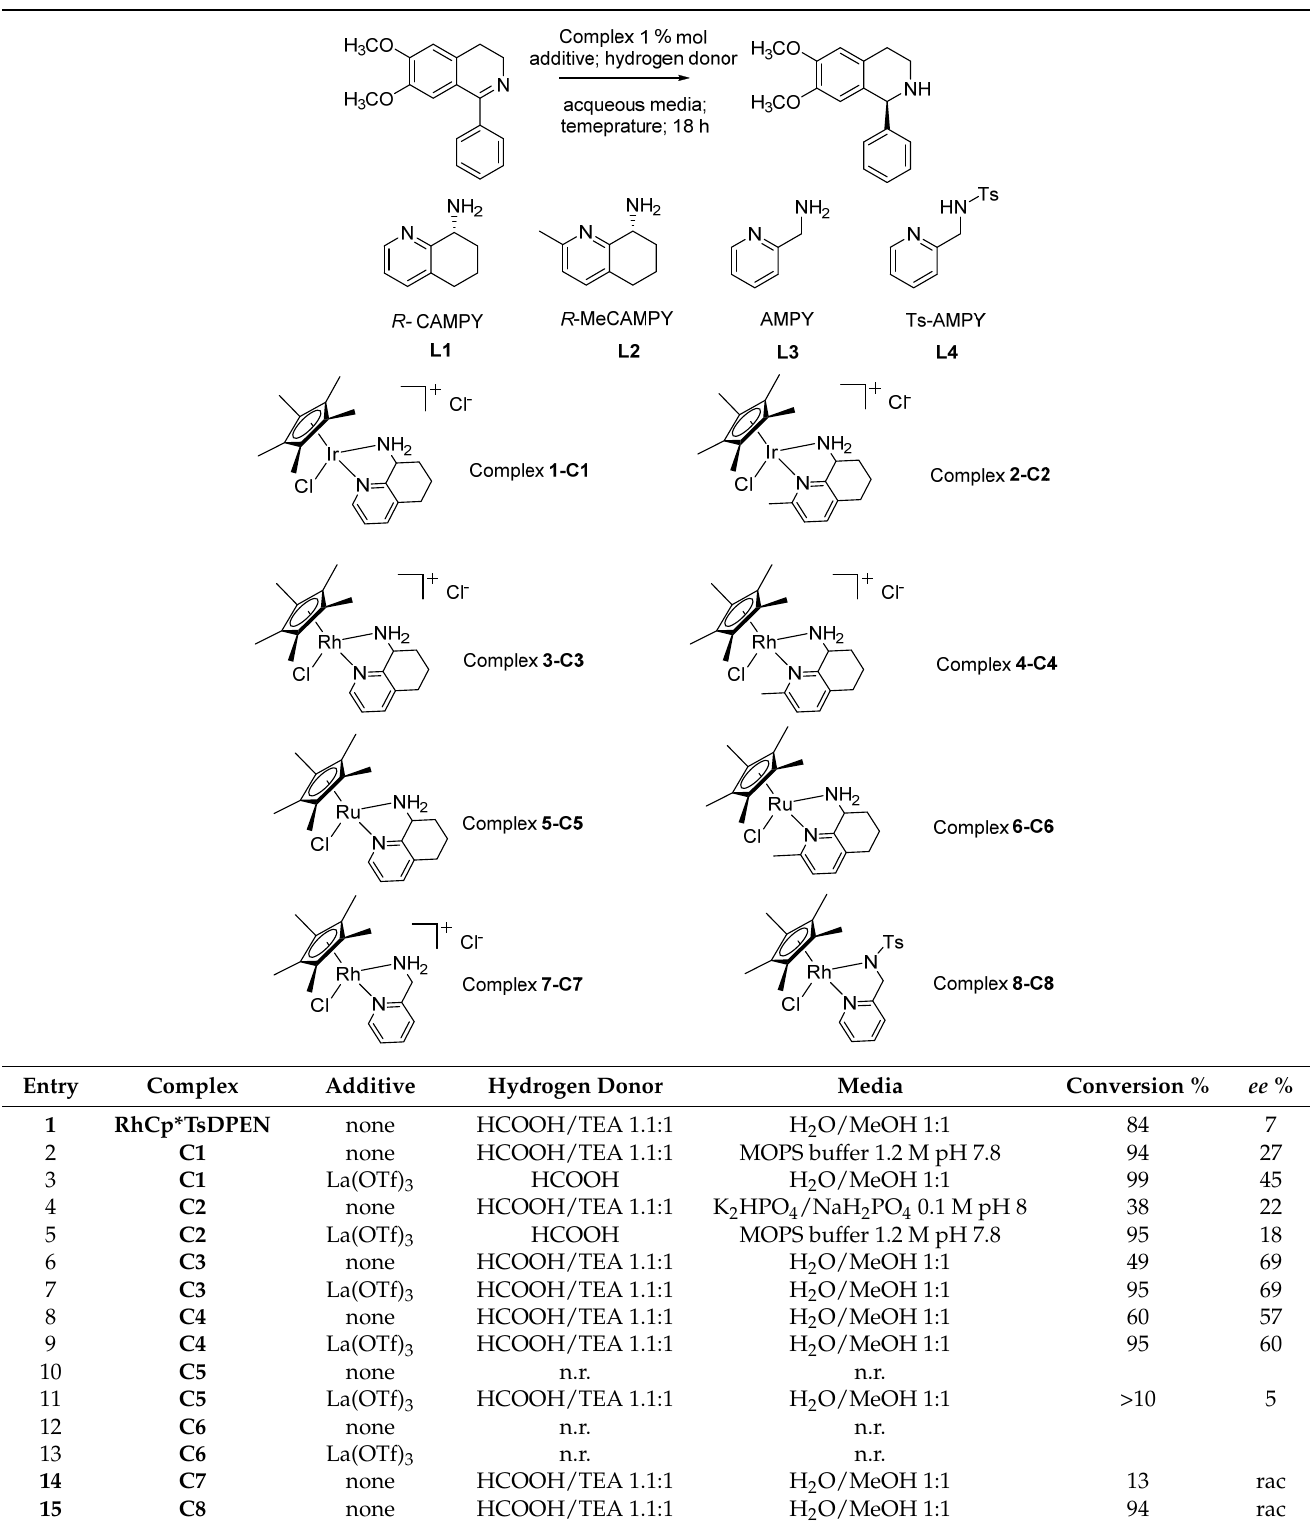
Table 1. Screening of different 1,2,3,4,5-pentamethylcyclopentadiene metal complexes in ATH of substrate I .